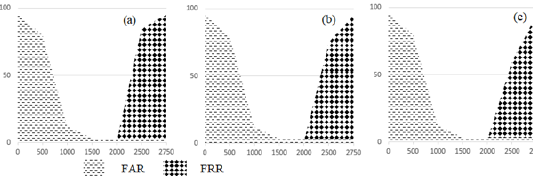
Figure 11. Analysis rate errors of Random Forest algorithm in 3 databases (( a ) BG-HLG, ( b ) FVC, ( c )